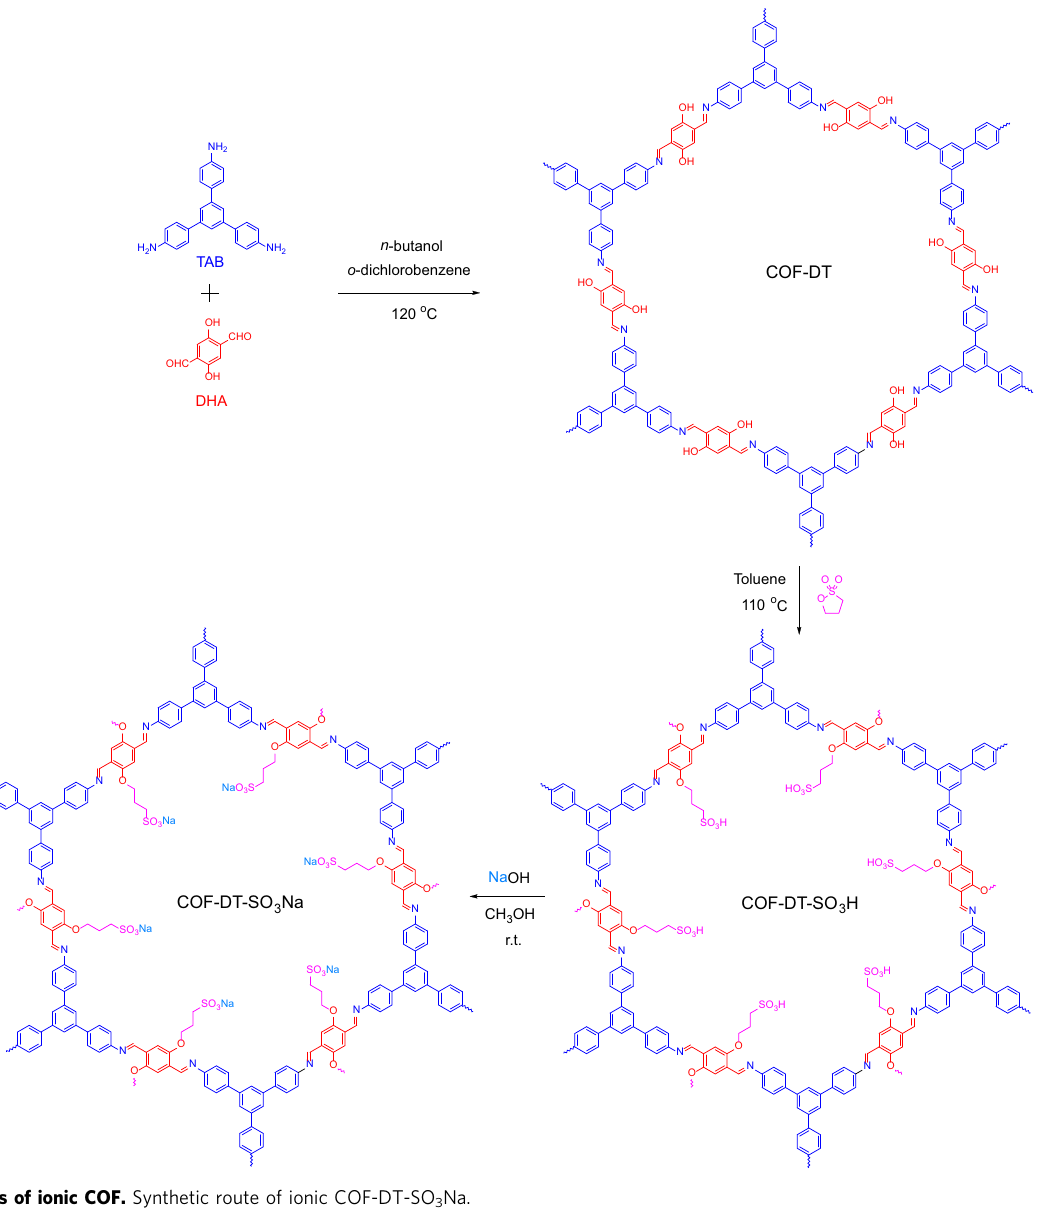
Fig. 1 Synthesis of ionic COF. Synthetic route of ionic COF-DT-SO 3 Na.